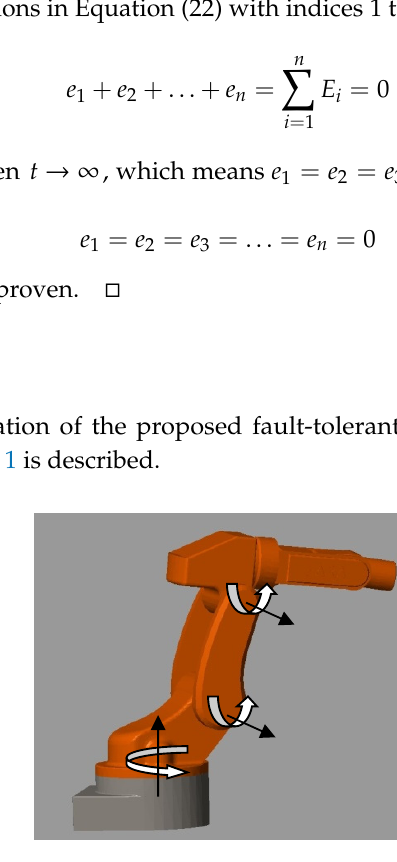
Figure 1. 3-DOF Robot Manipulator in MATLAB/Simulink.